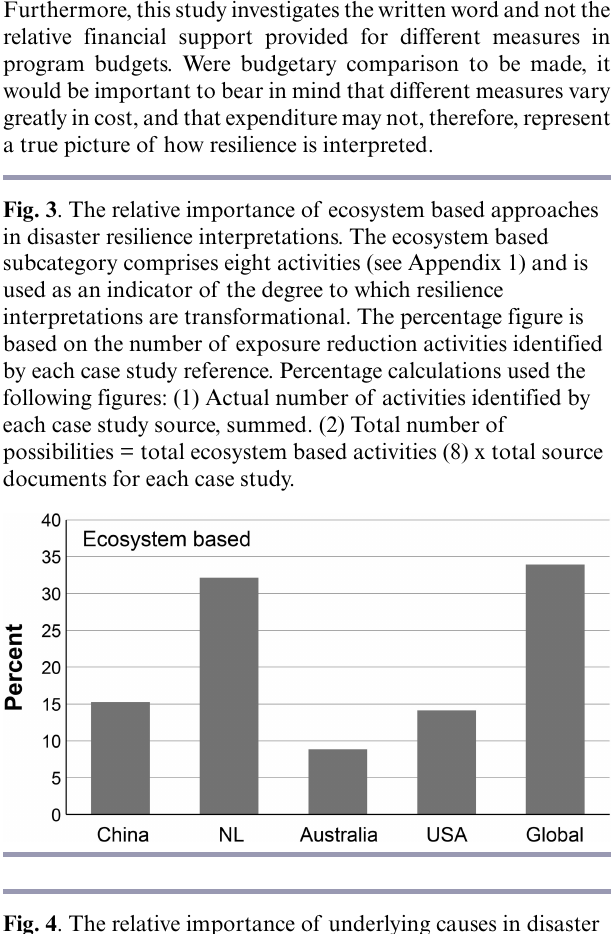
Fig. 4 . The relative importance of underlying causes in disaster resilience interpretations. The ability to understand and address underlying causes is indicative of a transformational approach.